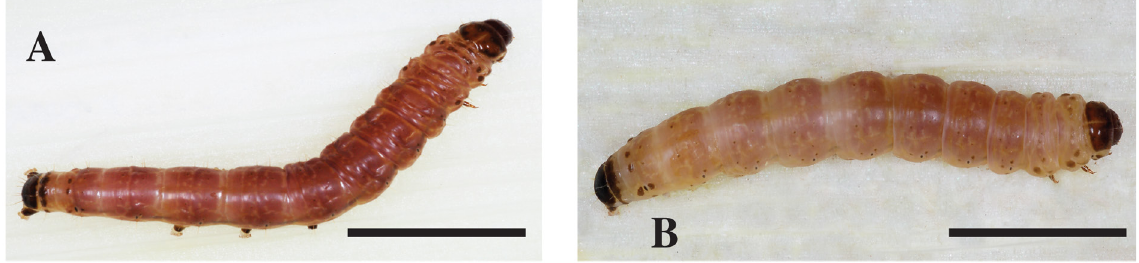
Fig. 9. Last instar larva. A . Acrapex simillima le Ru sp. nov. B . A. unicolora (Hampson, 1910). Scale bar = 10